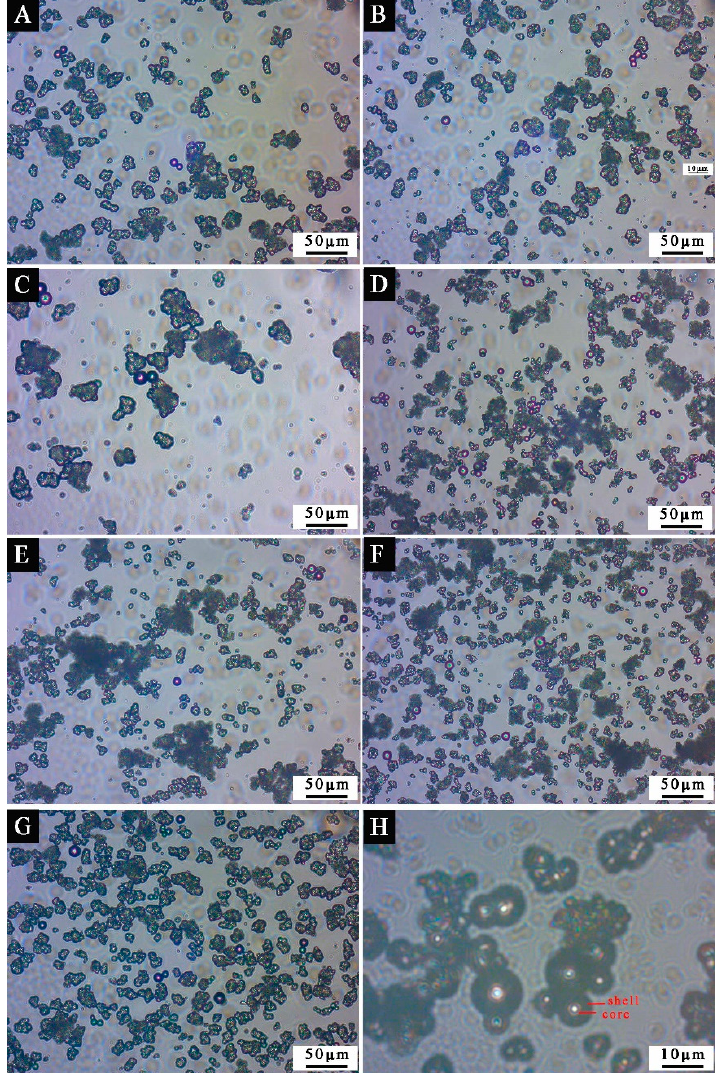
Figure 5. The OM appearance of microcapsules by single factor experiment: mass ratio of core to shell ( A ) 0.42:1, ( B ) 0.50:1, ( C ) 0.58:1, ( D ) 0.67:1, ( E ) 0.75:1, ( F ) 0.83:1, ( G ) 0.92:1, ( H ) 0.67:1.